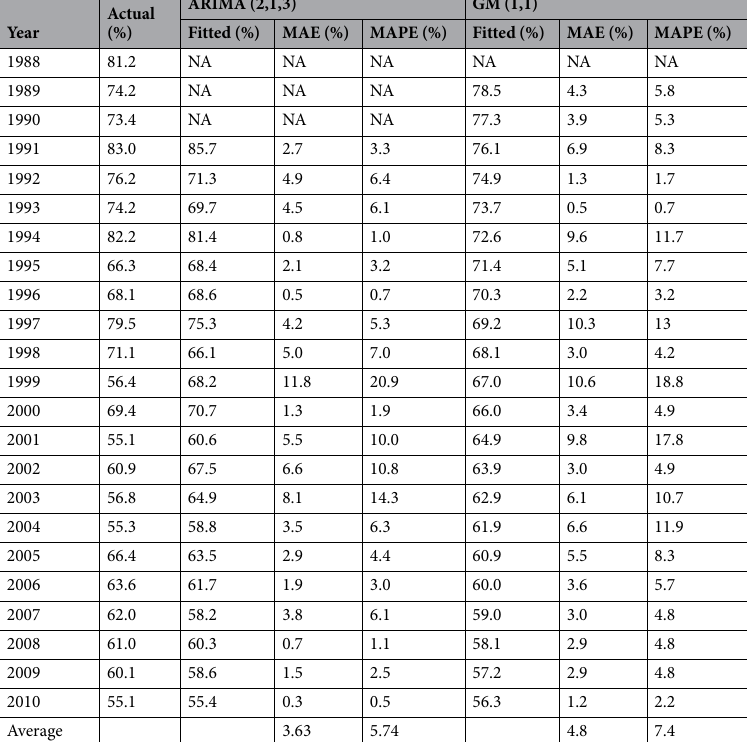
Table 2. Fitting results of two models.